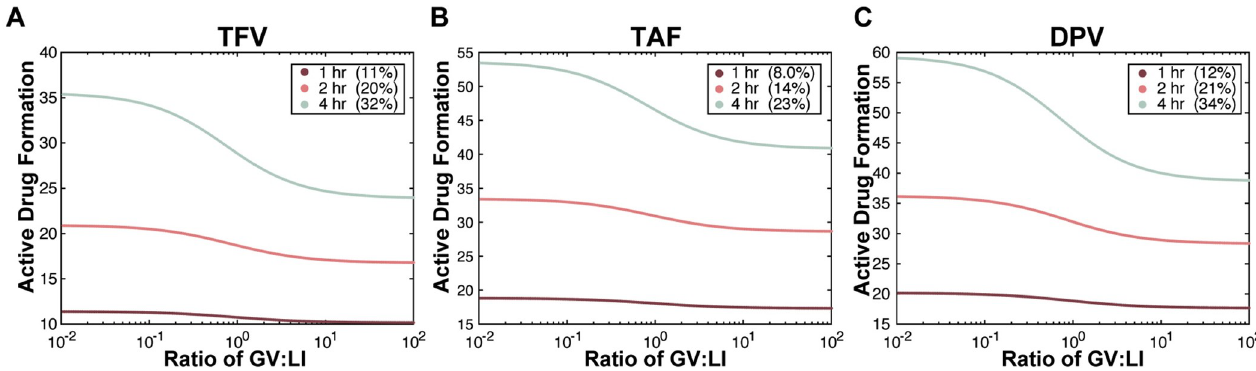
Fig 11. Time after MNZ treatment magnifies the effect of G . vaginalis on active drug formation. Simulations of active drug formation after 1hr, 2hr and 4hr post-treatment with MNZ at varying relative amounts of G . vaginalis to L . iners (GV:LI ratio) from 0.01-fold less G . vaginalis to L . iners to 100-fold more G . vaginalis to L . iners for (A) TFV; (B) TAF; and (C) DPV. The percent change from 0.01-fold GV:LB to 100-fold GV:LB active drug concentrations is listed in the